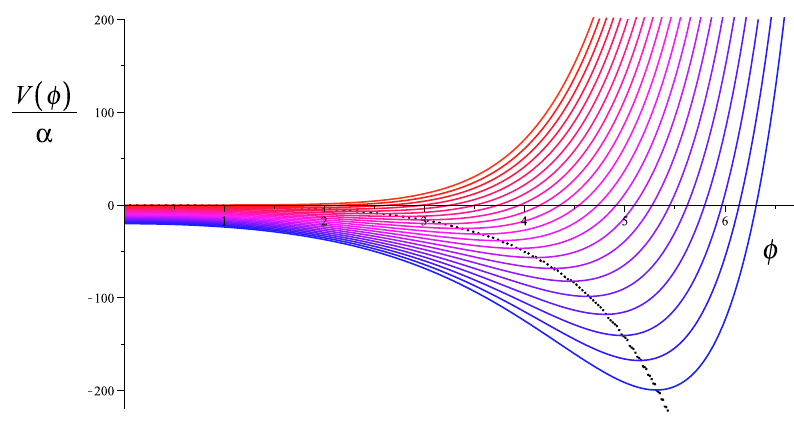
Figure 7 . The dilaton potential (over (cid:11) ) vs (cid:30) . Red curve at the top of the (cid:12)gure is the case (cid:3) = 0, while the curve in blue, at the bottom, corresponds to (cid:11) (cid:0) 1 (cid:3) = (cid:0) 10. Since V has the same dimension as (cid:11) and (cid:3), then (cid:11) (cid:0) 1 V and (cid:11) (cid:0) 1 (cid:3) are both dimensionless.